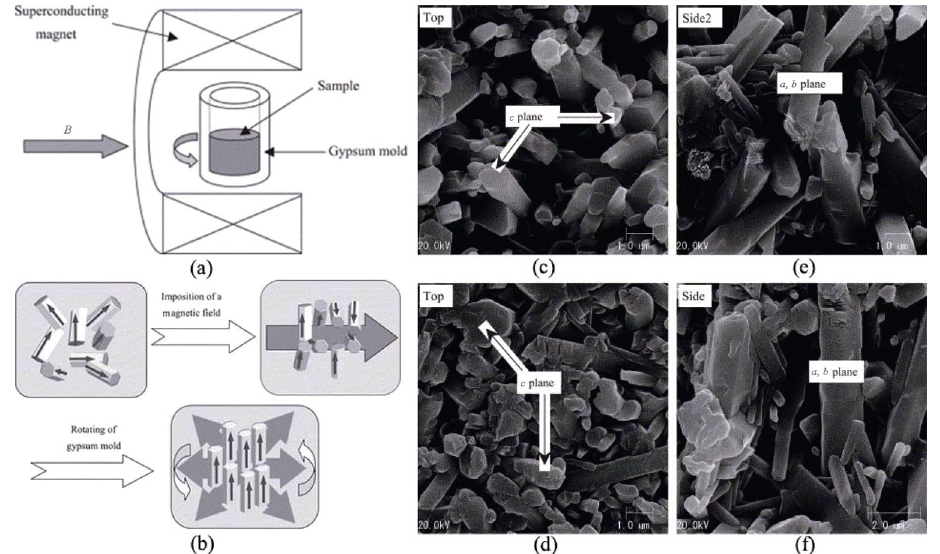
Fig. 26 Preparation and microstructures of textured Si 3 N 4 specimens by slip casting in a magnetic field: (a) schematic diagram of the experimental apparatus; (b) effect of the magnetic field and mold rotation on the orientation of rodlike Si 3 N 4 grains; (c, e) top and side surfaces of textured Si 3 N 4 specimens prepared without mold rotation during slip casting, respectively; (d, f) top and side surfaces of textured Si 3 N 4 specimens prepared in the magnetic field with mold rotation during slip casting, respectively. Reproduced with permission from Ref. [133], © Elsevier B.V. 2004.